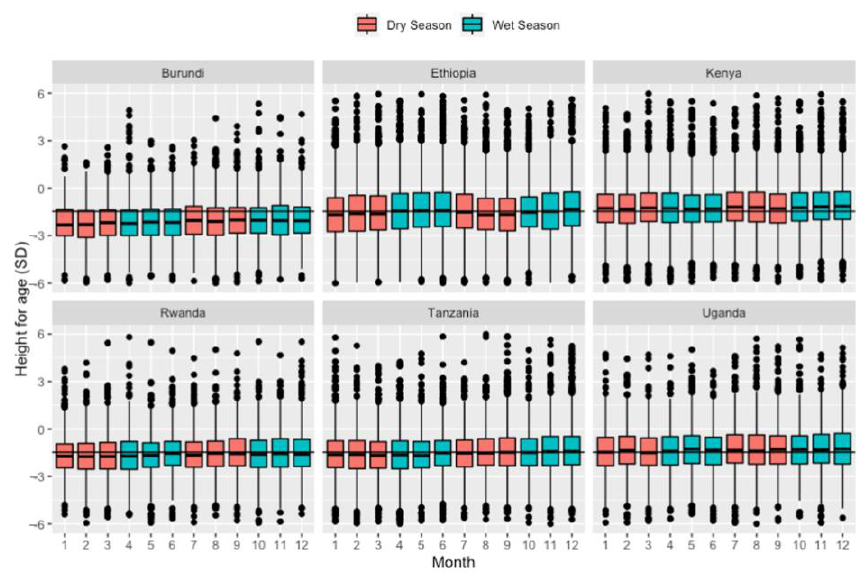
Figure 3. Height-for-age standard deviation by child’s month of birth for each country.